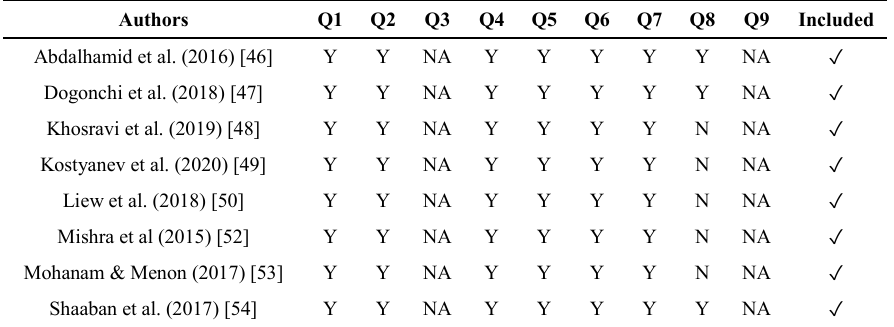
Table 2. JBI critical appraisal checklist for studies reporting prevalence